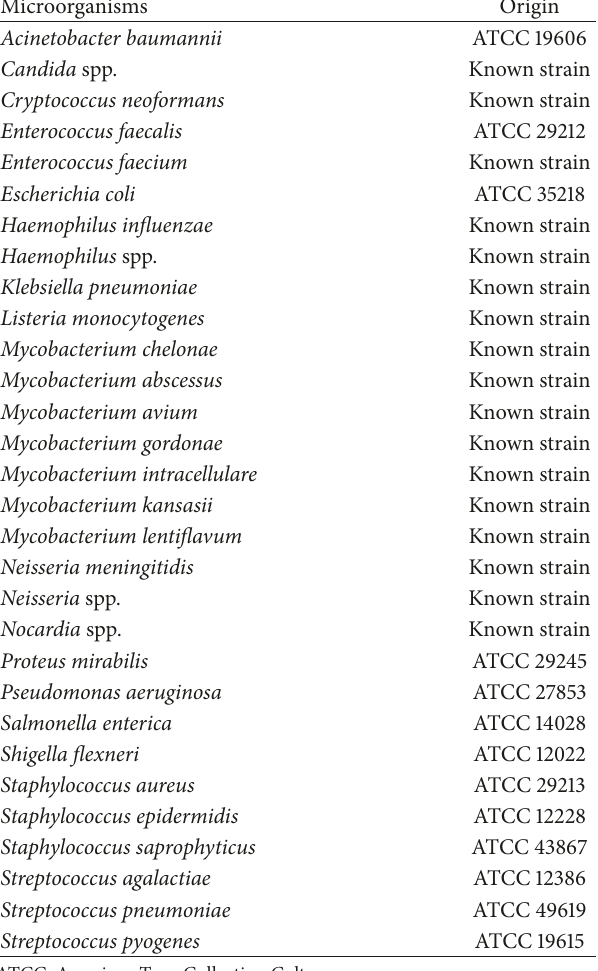
Table 2: List of microorganisms used as negative control.